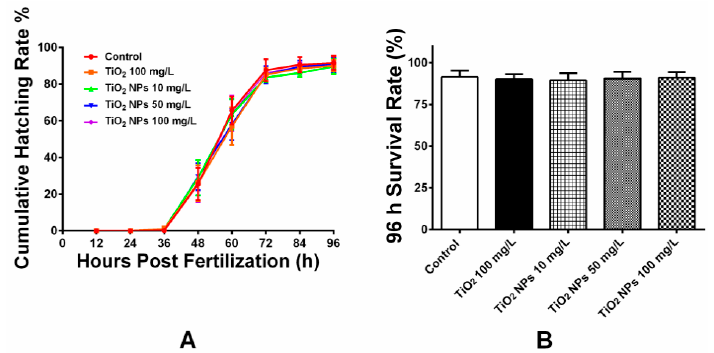
Figure 2. Hatching and survival rate of zebrafish embryos. ( A ) Hatching rate of zebrafish embryos induced by E3 solution, bulk TiO 2 and different concentration TiO 2 NPs for 0–96 hpf. The results showed no strong inhibition of hatching rate after embryos exposed to TiO 2 nanoparticles; ( B ) Percentage of surviving embryos after 96 h of exposure. Results are presented as mean ± SD from five independent experiments ( n = 200, 40 embryos in 5 replicates